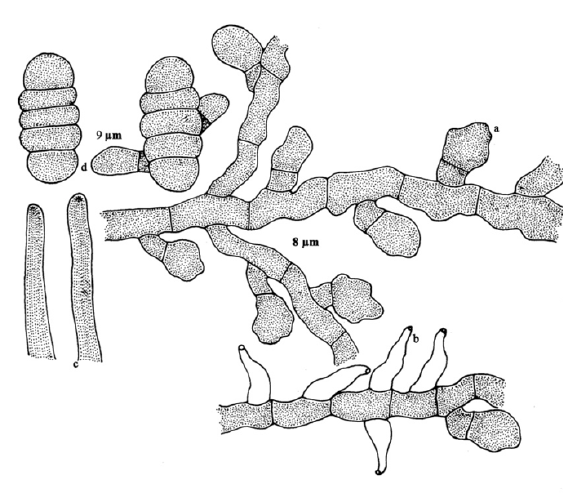
Figure 108. Meliola plectroniae a - Appressorium; b - Phialide; c - Apical portion of mycelial setae;